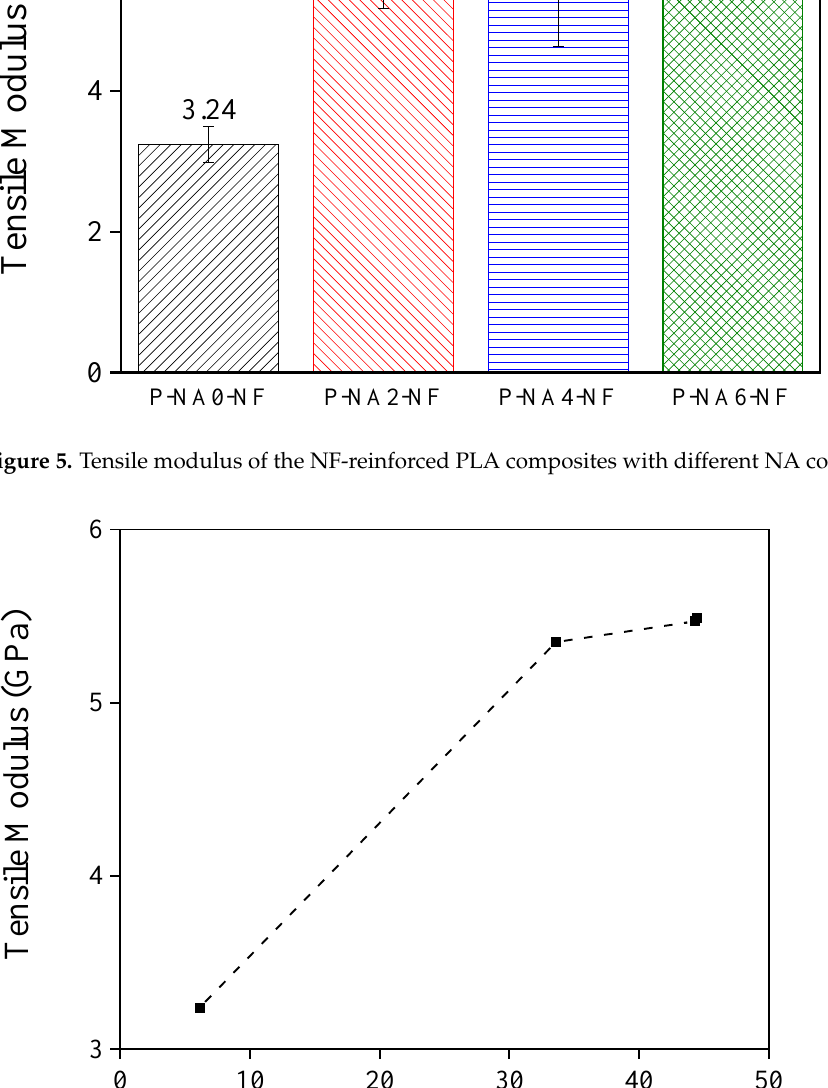
Figure 6. Tensile modulus of the NF-reinforced PLA composites with different NA contents as a function of percentage crystallinity.